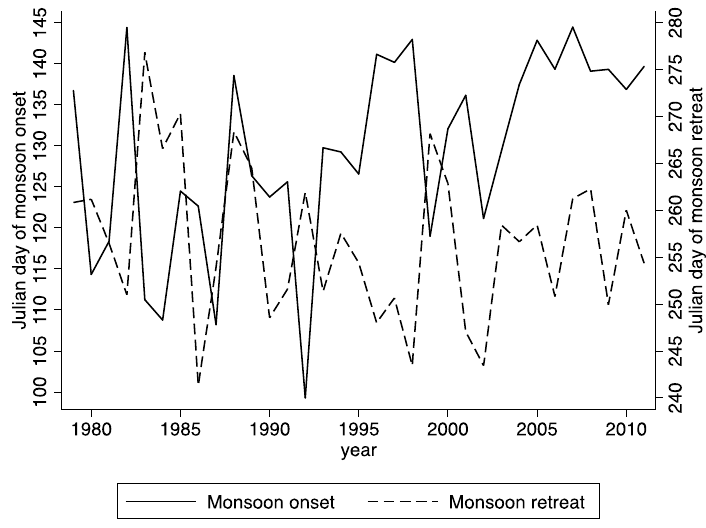
Figure 7. Based on our estimation of the monsoon period, this graph shows the average date of the onset and retreat of the monsoon in the 15 provinces in China where tea is grown over the study period (1980–2011).